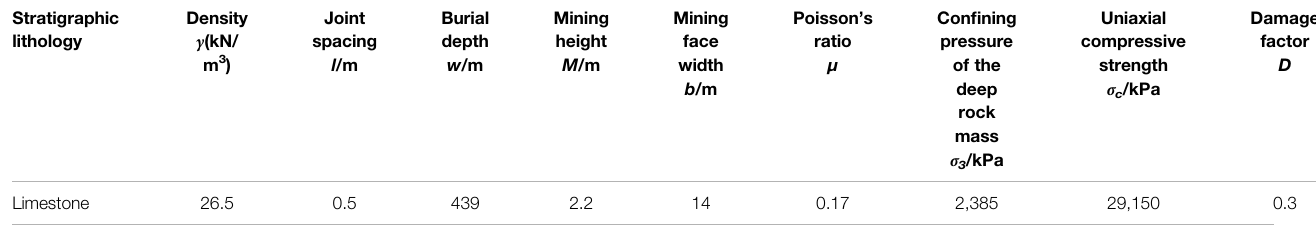
TABLE 2 | Calculating parameters of HWCFZ in Zengziyan Bauxite.